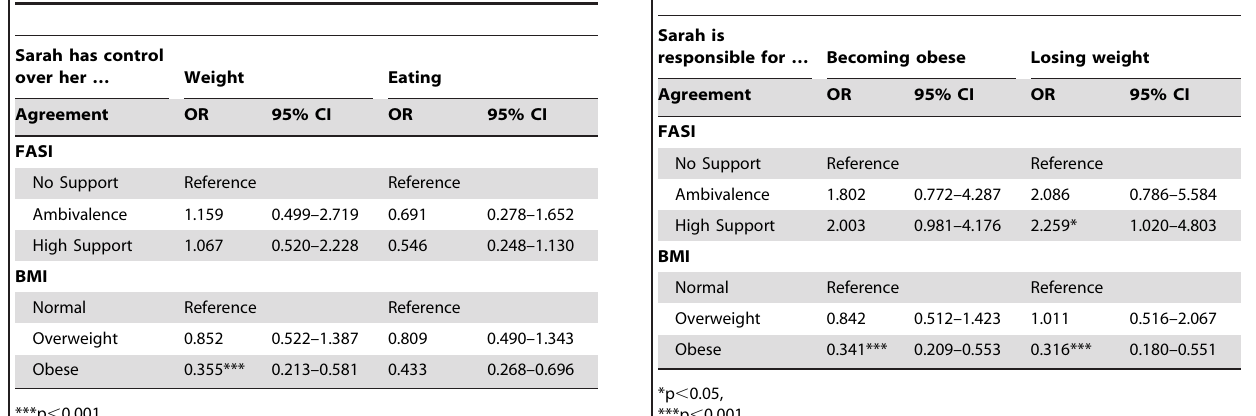
Table 4. Impact of food addiction support and BMI on responsibility based on responses to the